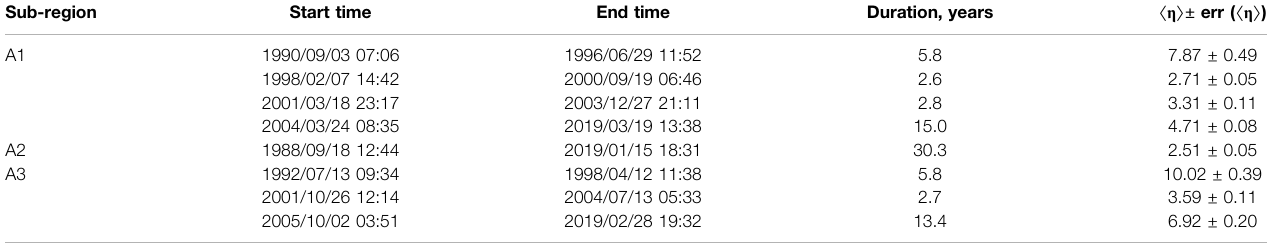
TABLE 6 | Periods of stability of the USLE control parameter 〈 η 〉 for three Friuli-Venezia Giulia sub-regions. Sub-region Start time End time Duration, years 〈 η 〉 ± err ( 〈 η 〉 )